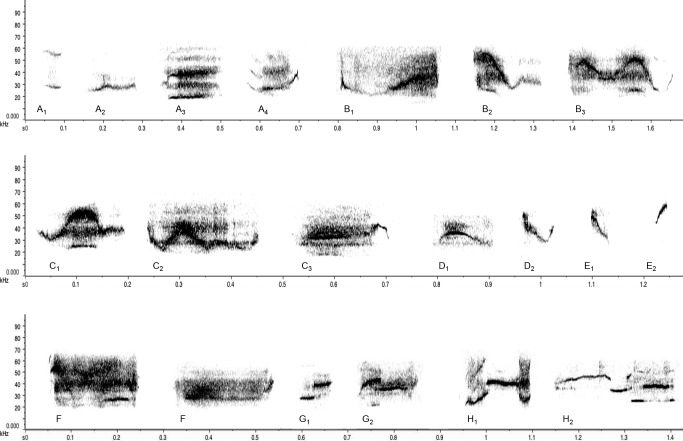
Spectrograms of typical call types produced by golden hamsters after interacting with a stimulus hamster of the opposite-sex.Call subtypes are merged into 8 major categories of call types: A. Flats (Flat1–3, 2tail-flat4), B. Waves (Wave down-up1, Wave up-down2, Complex wave3), C. Humps (Center hump1, Left hump2, Right hump3), D. Chevrons (Chevron-down1, Chevron-up2), E. Sweeps (Down-sweep1, Up-sweep2), F. Broadband, G. 1-Frequency jump (1-Jump up1, 1-Jump down2), H. Multi-Frequency jumps (2-Step1, 3+Step2).